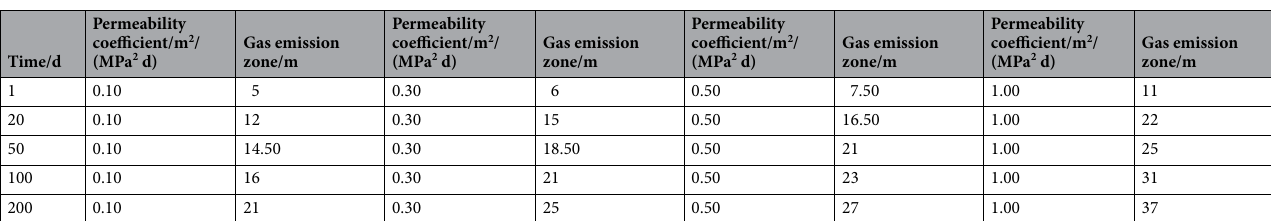
Table 3. The results of simulation under different permeability